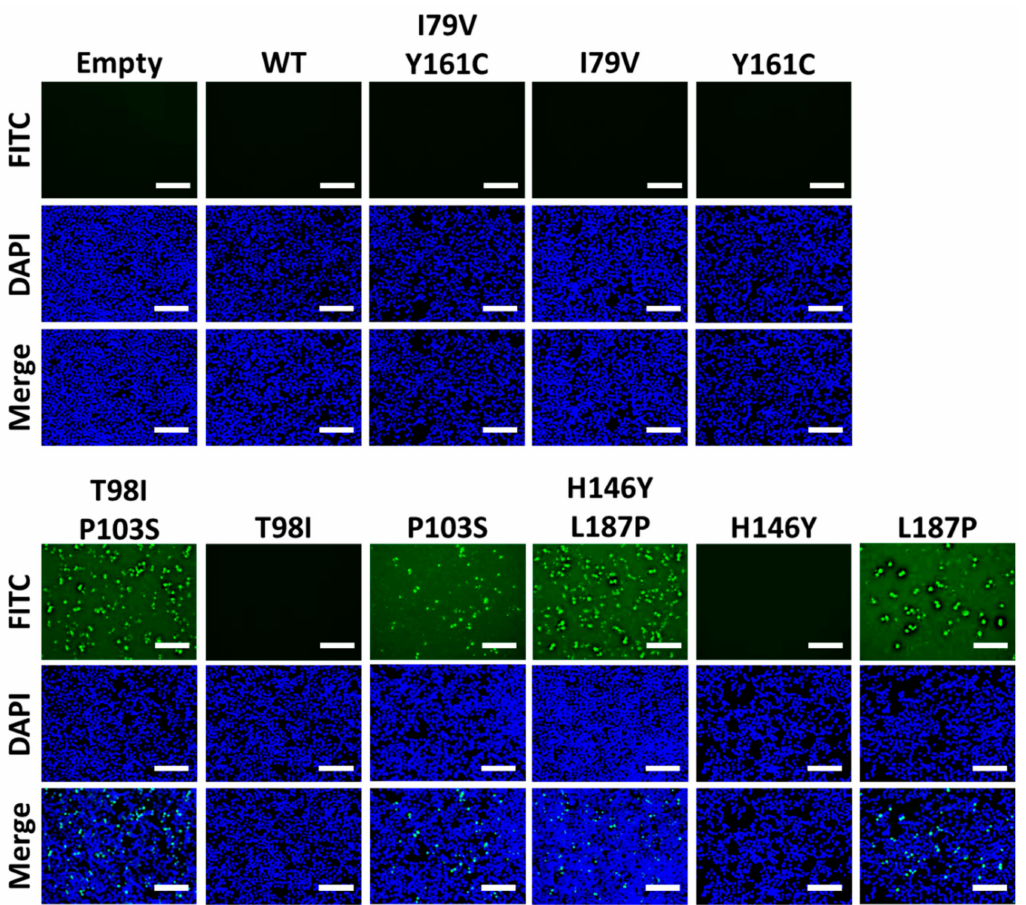
Figure 6. Effect of double and single-amino acid mutants on the expression of the PA-X proteins: HEK293T cells (24-well plate format, 5 × 10 4 cells/well) were transfected with 1 µ g of pCAGGS 1918 PA-X HA-tagged double or single mutant plasmids. Empty and 1918 PA-X WT pCAGGS expression plasmids were included as internal controls. At 24 h p.t., cells were fixed, permeabilized, and immunostained with PAb against the HA epitope tag (green). DAPI was used to stain the nucleus of transfected cells (blue). Magnification 20 × , scale bar = 100 µ